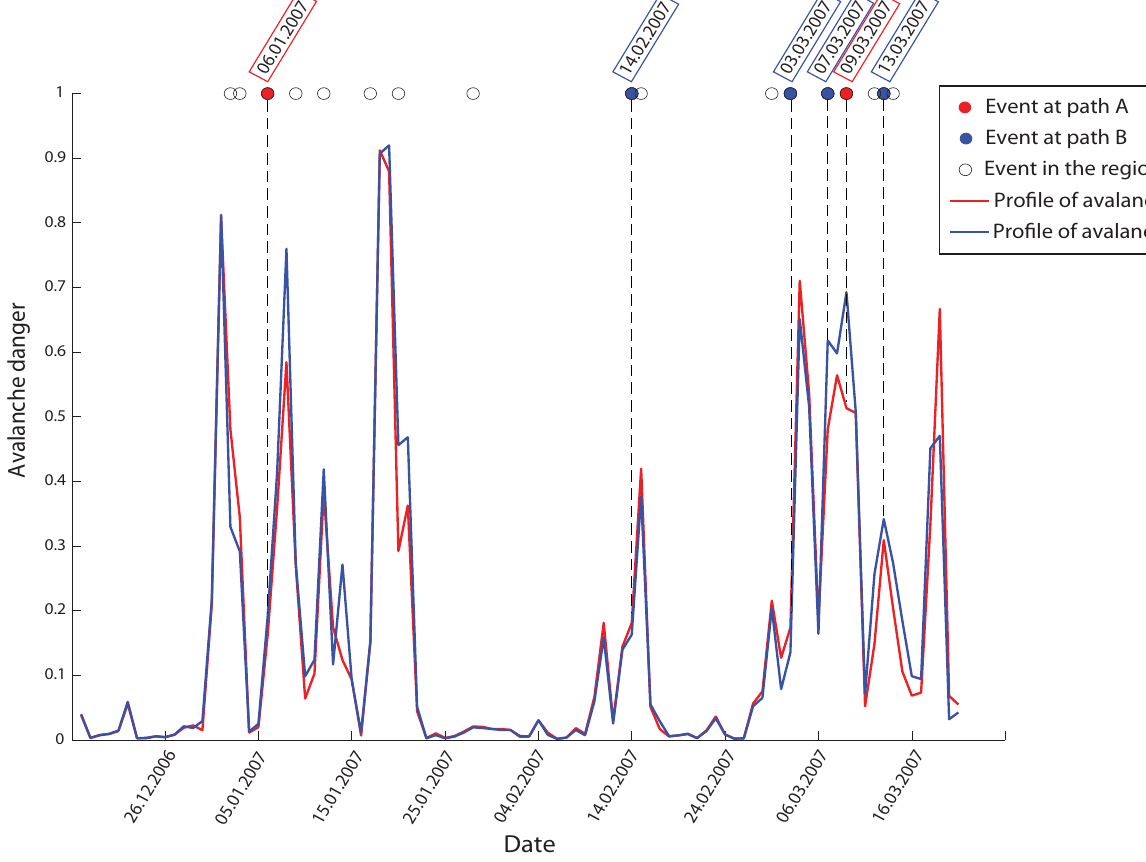
Fig. 5. Evolution of avalanche danger for gullies A and B during the winter season of